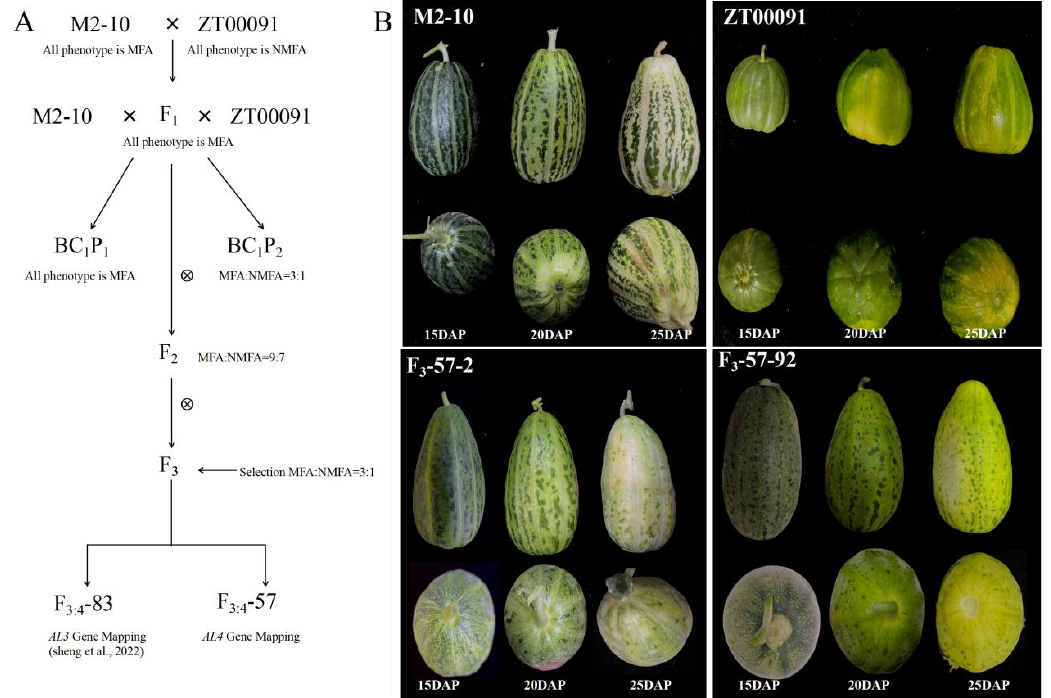
Figure 1. Technology roadmap and phenotype of M2-10 and ZT00091. ( A ): Technology roadmap of this study. ( B ): Phenotype of M2-10 and ZT00091. Each material had three fruits from 15 DAP (days after pollination), 20 DAP, and 25 DAP. For M2-10, fruit matured about 32 days after pollination and without abscission until ripen. Fruits of ZT00091 became mature from 28 DAP but started to abscise from ~25 days. F 3 -57-2 and F 3 -57-92 were the F 3 family of No.57 from M2-10 crossing with ZT00091, the fruit of which were without mature abscission and with mature non-abscission, re- spectively.